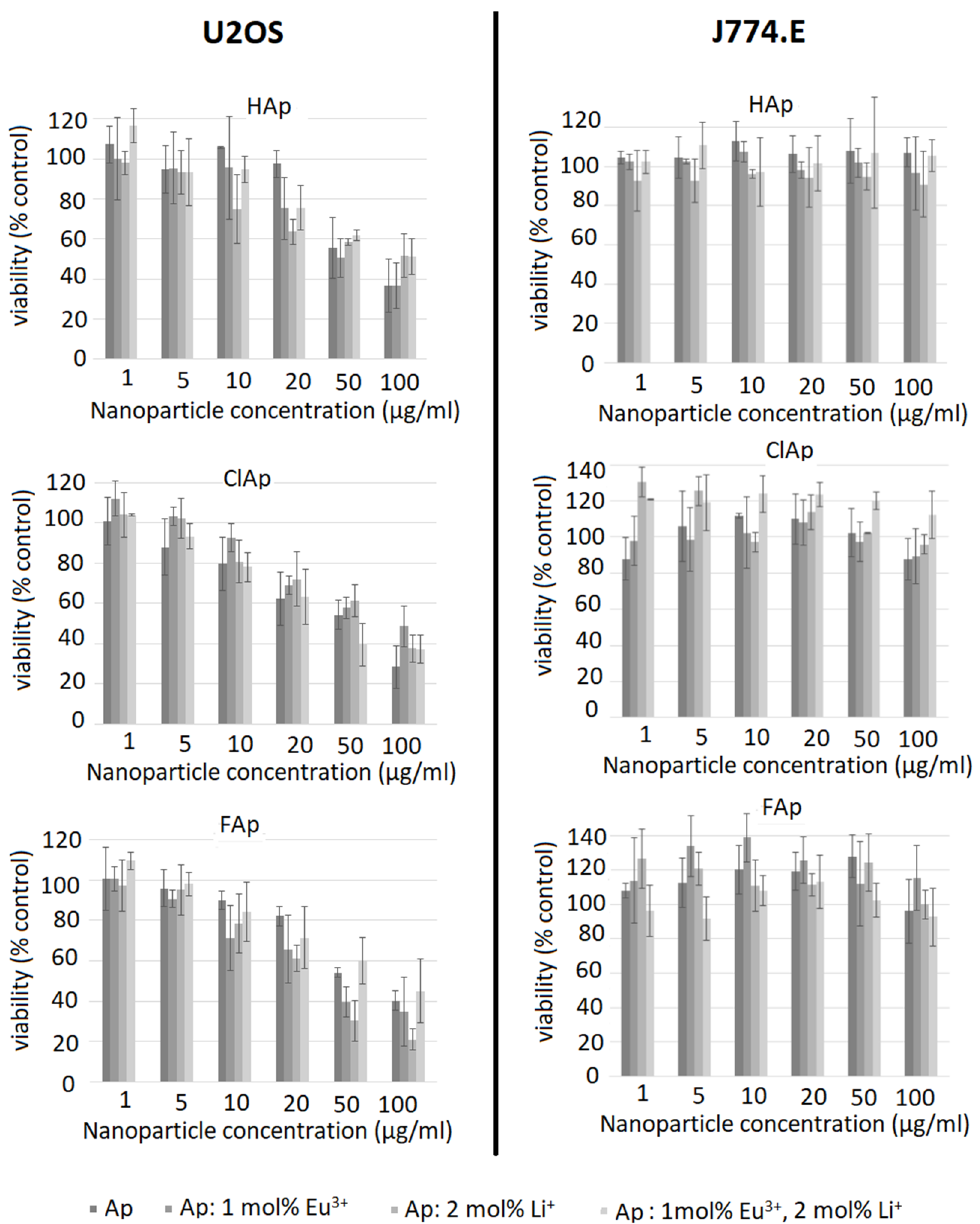
Figure 10. Influence of un-doped nanoapatites (Ap-HAp, ClAp, FAp) as well as nanoapatites doped and co-doped with Eu 3+ /Li + ions on viability of U2OS human osteosarcoma cells ( left panel ) or J774.E murine macrophages ( right panel ) determined by the trypan blue exclusion assay (TBEA) after 48 h exposure.